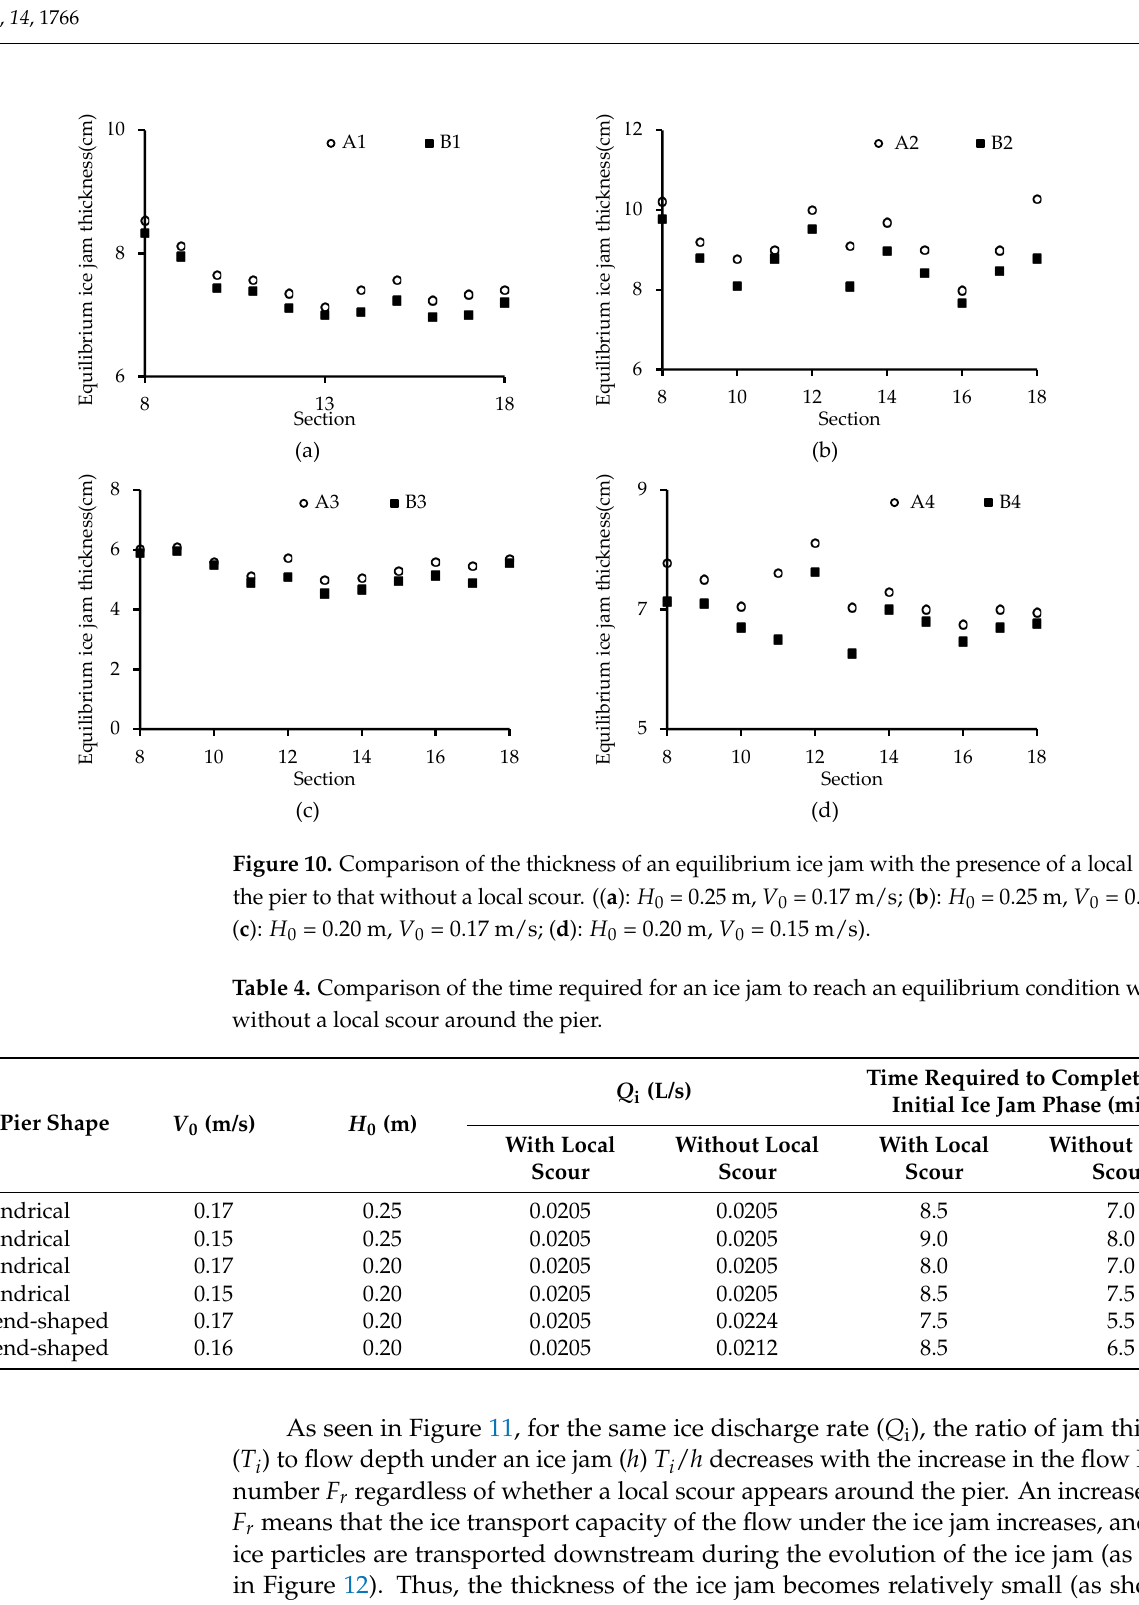
Table 4. Comparison of the time required for an ice jam to reach an equilibrium condition with and without a local scour around the pier.